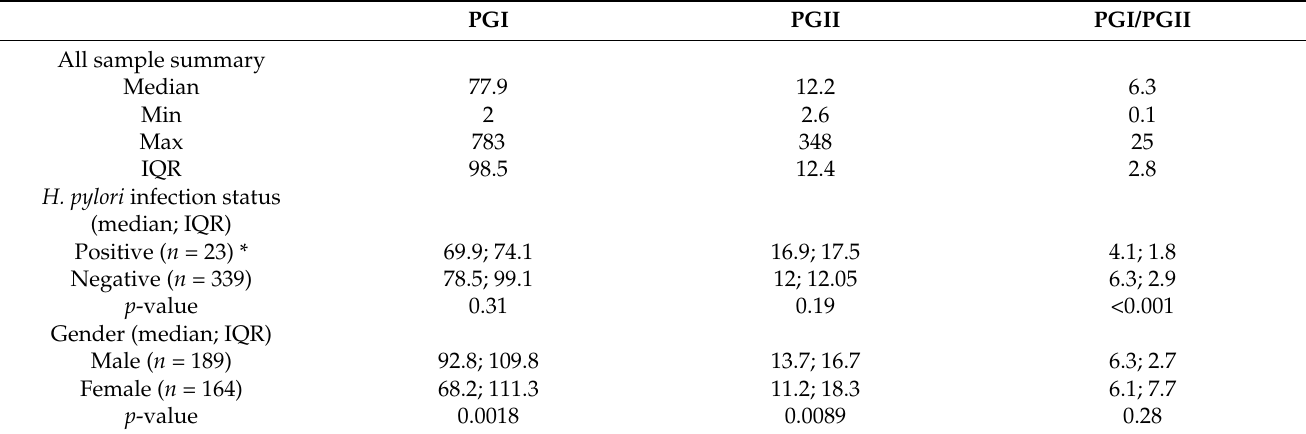
Table 3. Pepsinogen level by H. pylori infection status and gender.